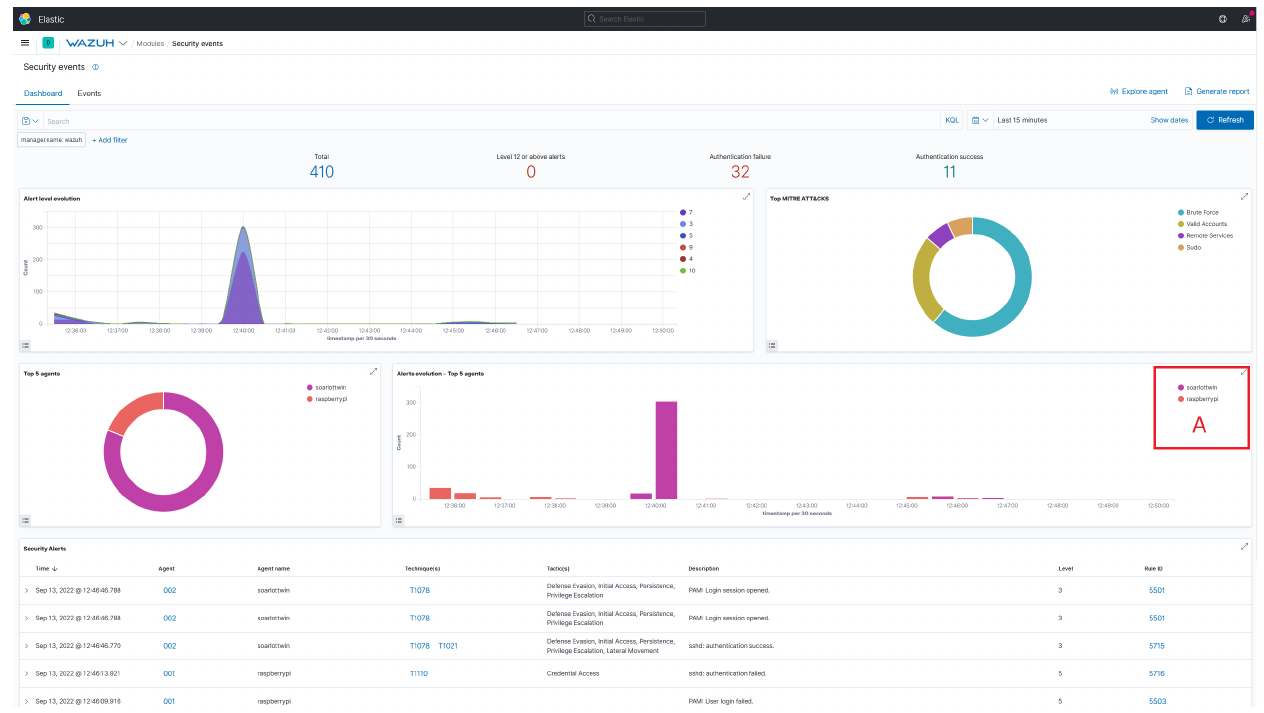
Figure A1. Analyzing all events of all assets in Wazuh (A shows all